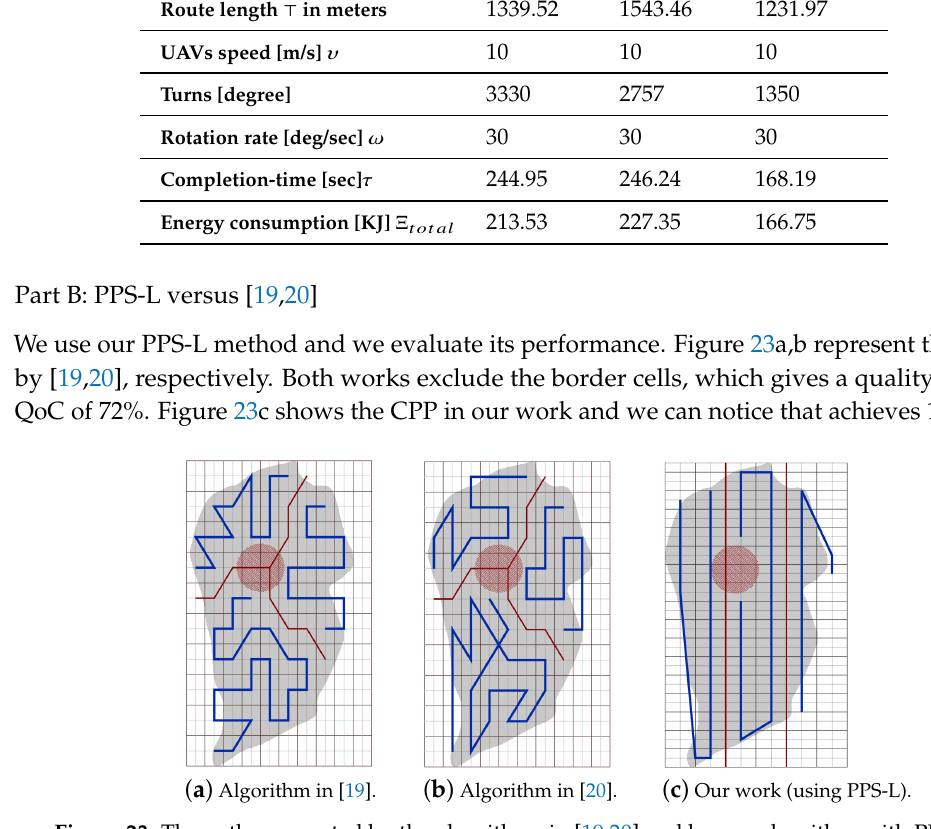
Figure 23. The paths generated by the algorithms in [19,20] and by our algorithm with PPS-L.